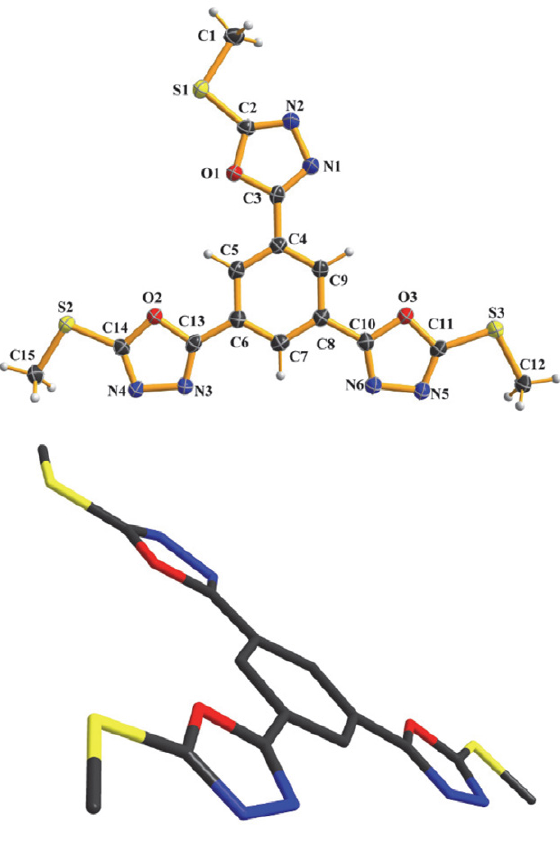
Figure 1. Molecular structure of L (50% probability displacement ellipsoids), front and side views are